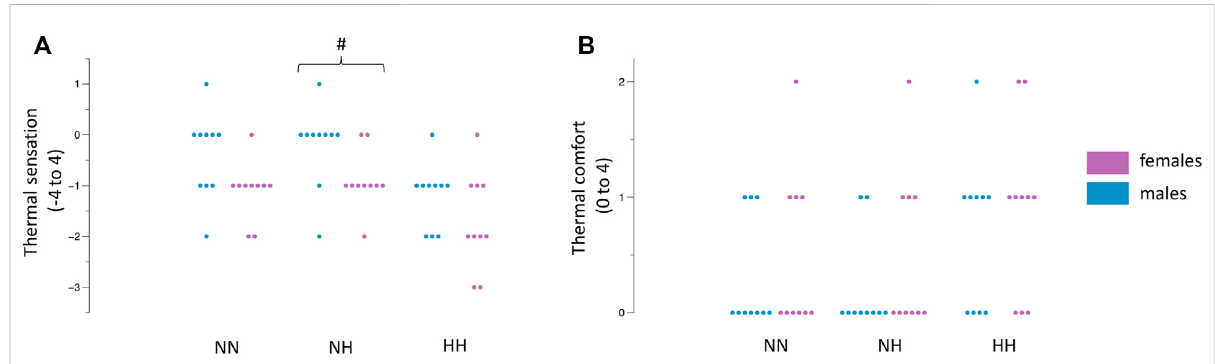
FIGURE 3 DifferencesbetweenfemalesandmalesinNN,NHandHHforthermalsensation (A) andthermalcomfort (B) .Dotsindicatetheindividualvalues of each participant. # p = 0.02 between females and